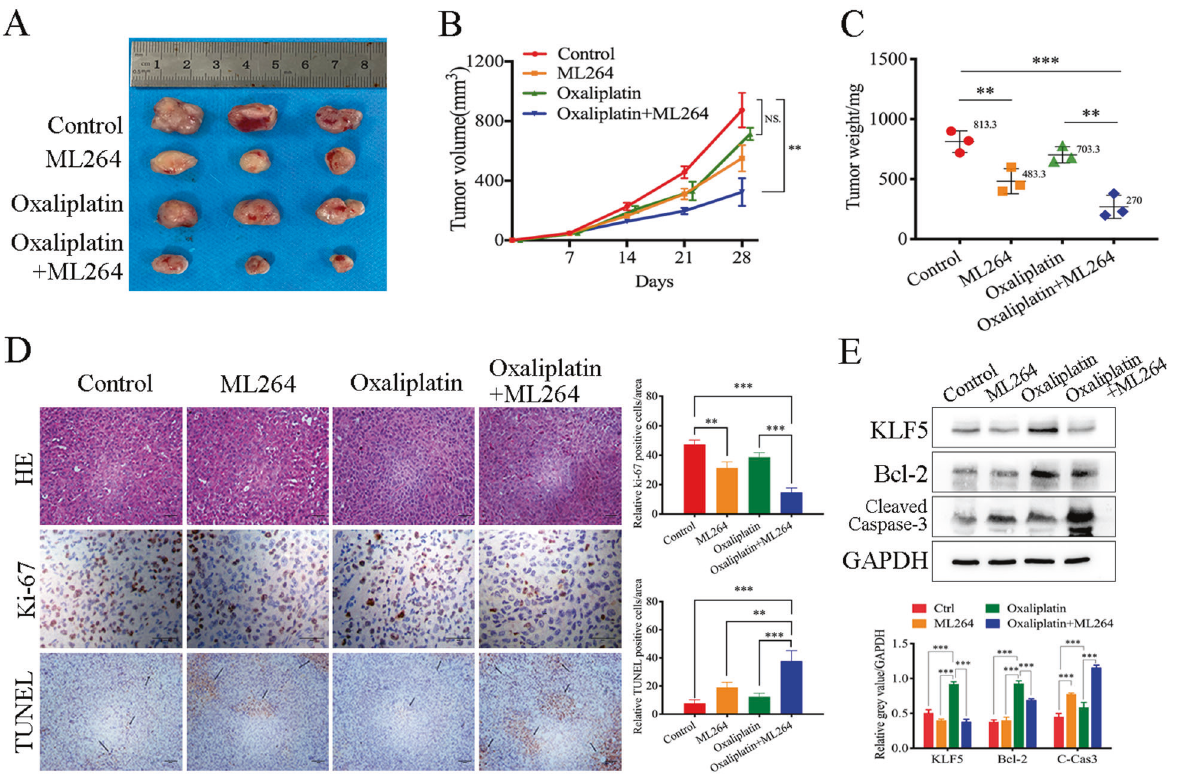
Fig. 6 Inhibition of KLF5 overcomes oxaliplatin resistance in xenograft tumors. A , B Nude mice were injected s.c. with CRC cells. After tumor diameter reached approximately 5 mm, mice were treated with oxaliplatin alone or in combination with ML264 as indicated. Tumor volume at indicated time points was calculated and plotted (mean ± SD, n = 3 for each group, one-way ANOVA, ** P < 0.01, NS not signi fi cant). C The combined use of ML264 can signi fi cantly inhibit tumor growth in xenograft tumors (mean ± SD, n = 3 for each group, one-way ANOVA, ** P < 0.01, *** p < 0.001). D TUNEL and Ki-67 immunostaining were used to analyze the apoptosis level of xenograft tumors. Arrows indicate example cells with positive staining. ML264 signi fi cantly restored the oxaliplatin-induced tumor apoptosis (mean ± SD, n = 3 for each group, one-way ANOVA, ** P < 0.01, *** p < 0.001). Scale, 200 μ m. E Western blotting was used to analysis KLF5, Bcl-2 and cleaved caspase 3. The concentration of ML264 was 25 mg/kg, and the concentration of oxaliplatin was 5 mg/kg (mean ± SD, n = 3 for each group, one-way ANOVA, ** P < 0.01, *** p < 0.001).